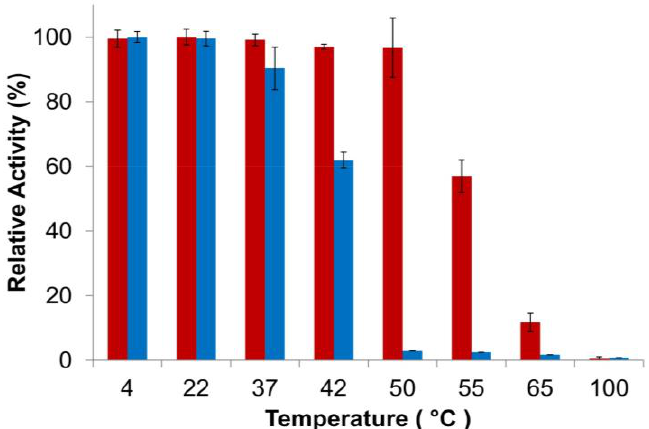
Figure 4. Thermostability of PlyGVE2CpCWB and PlyCP26F. The proteins were incubated